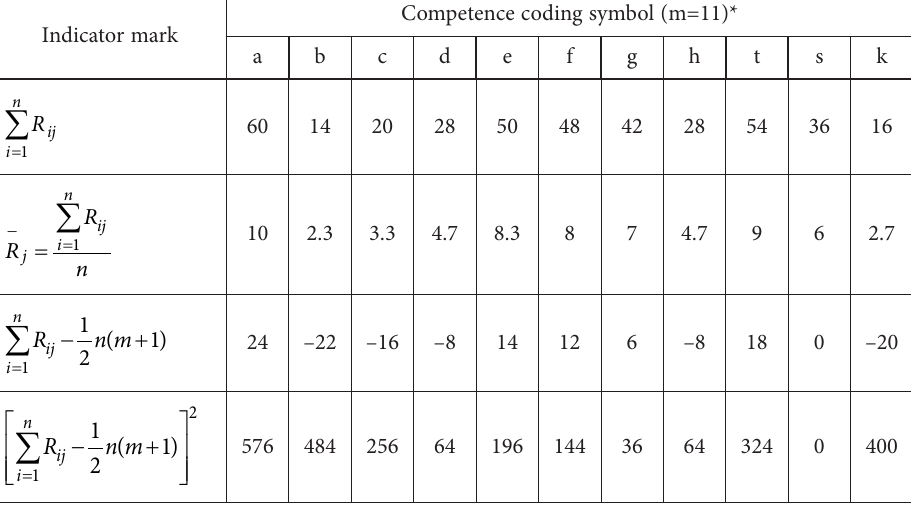
Table 2. Summarizing indicators of competence assessment of logistics managers (compiled by the authors based on Sivilevičius, 2011) Indicator